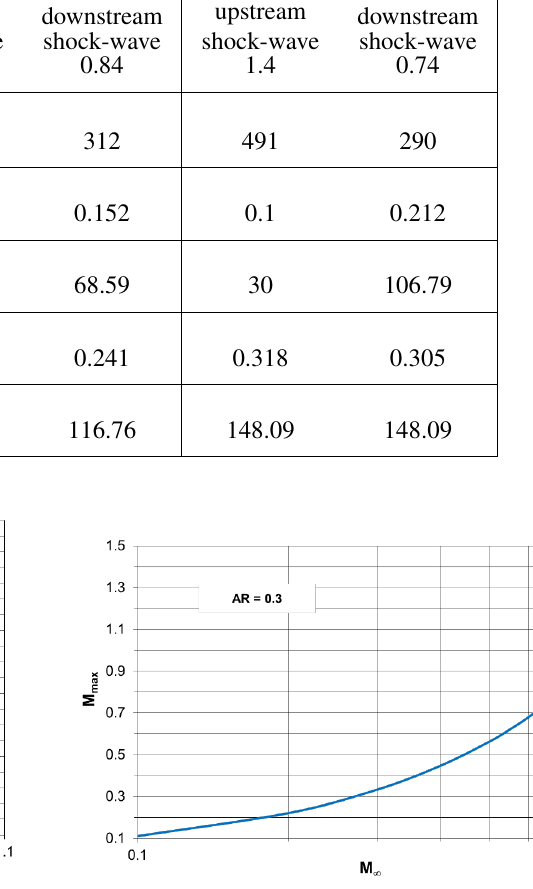
Fig. 9. Graph of the maximum Mach number M max as a function of free stream Mach number M ∞ on an ellipsoid of revolution of the aspect ratio AR = 0 . 3 .